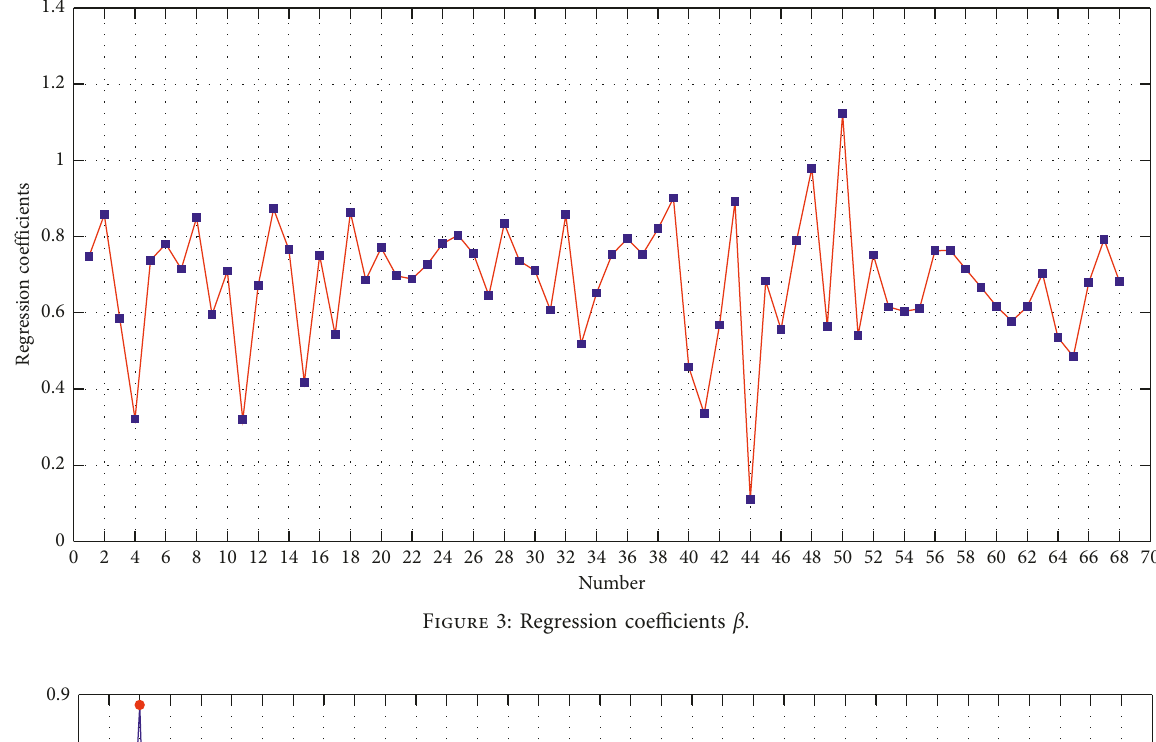
Figure 3: Regression coefficients β .